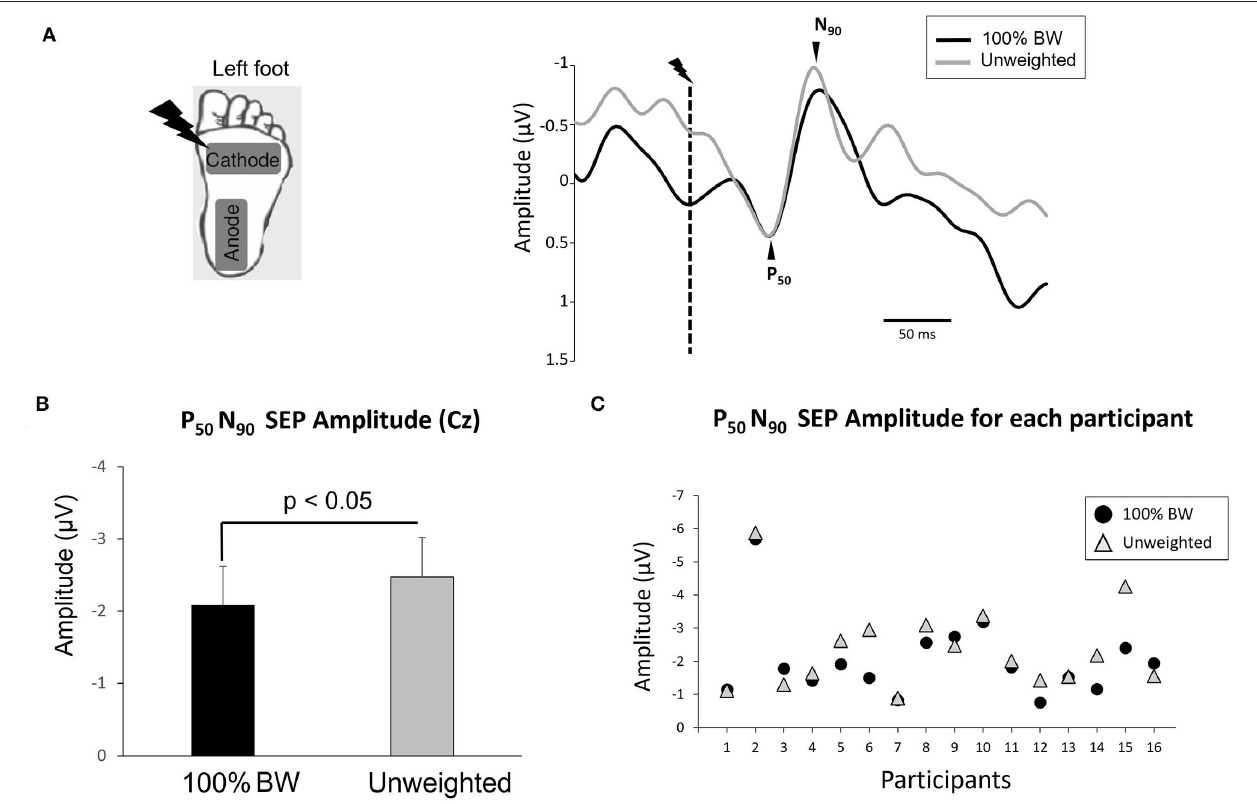
FIGURE 1 | (A) (left panel) Position of stimulation electrodes underneath left foot. (right panel) Average of the somatosensory evoked potential for all participants over Cz electrode in 100% BW and unweighted conditions synchronized to the electric stimulation (dashed line). Note that for the figure, only we have superimposed the two conditions relative to the P50 amplitude. (B) Mean amplitude of the averaged P50N90 SEP evoked by the electric stimulation during 100% BW and unweighted condition for all participants (error bars are standard error across participants). (C) Amplitude of the averaged P50N90 SEP for each